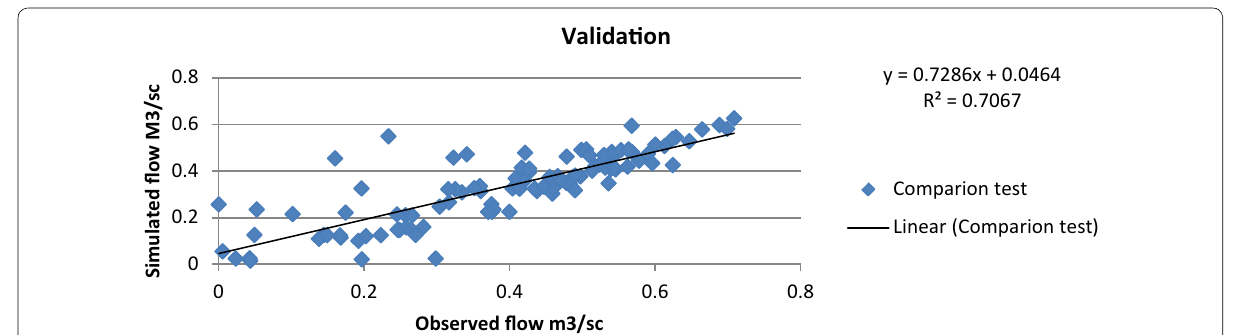
Fig. 9 Observed verse simulated to flow during